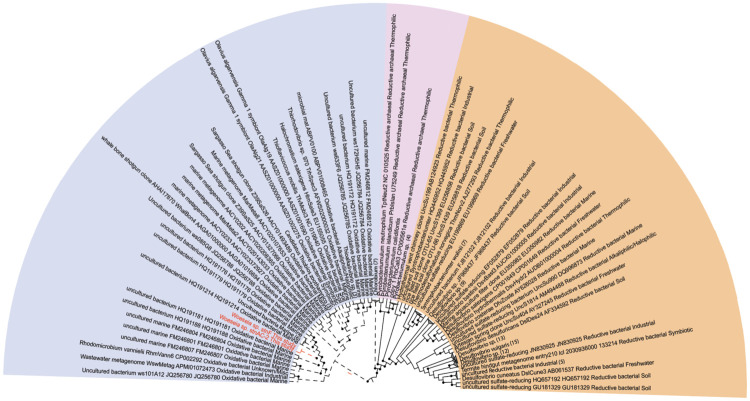
Phylogeny of DsrA encoded on Woeseiales MAGs.The CIPRES Science Gateway v. 3.3 online server was used for RAxML and the tree was visualized with the Interactive Tree of Life (iToL) visualization tool. Nodes with bootstrap values equal to or greater than 70% are indicated with a black circle. Reductive-type archaeal and bacterial sequences are represented in pink and orange fields, respectively, with solid tree branches. Oxidative-type bacterial sequences are represented in the blue field with dashed tree branches. Woeseiales DsrA sequences are highlighted in red text.